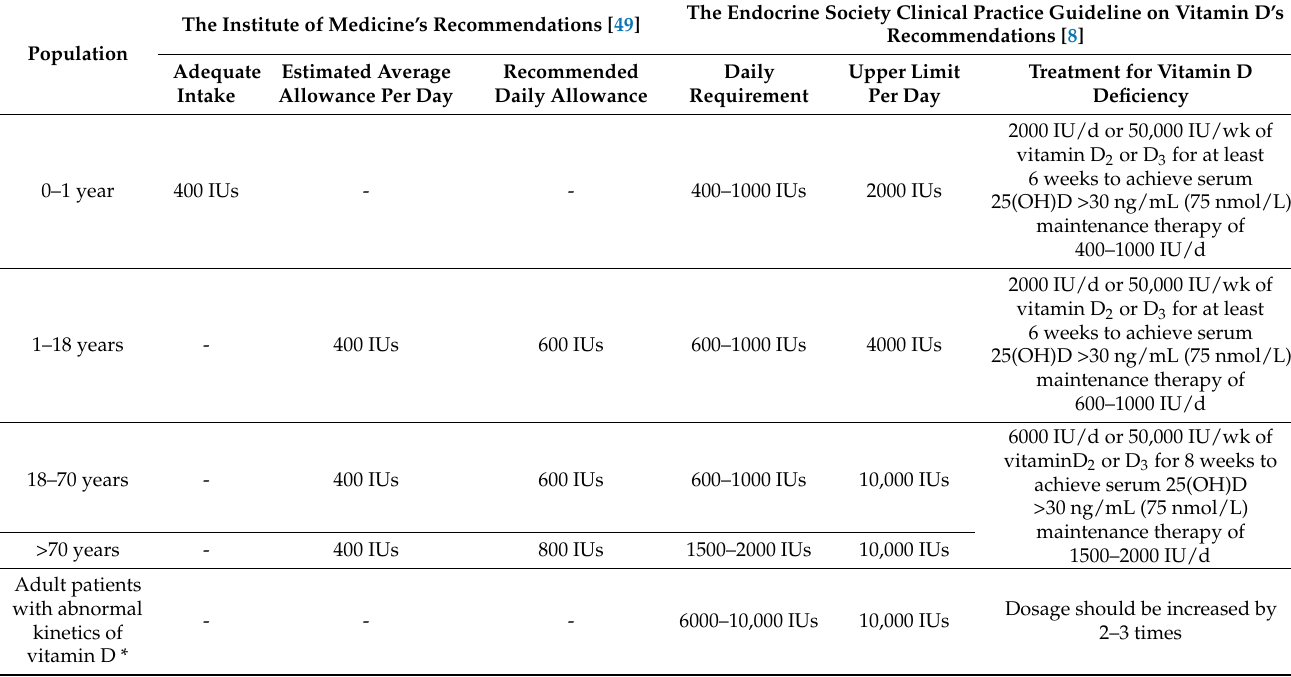
Table 1. Recommendations for daily intake of vitamin D and treatment for vitamin D